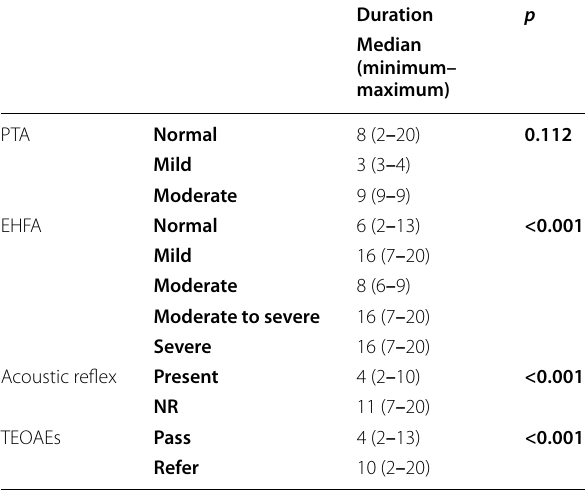
RF rheumatoid factor, ACCP anti-cyclic citrullinated peptide, PTA pure tone audiometry, EHFA extended high-frequency audiometry, AR acoustic